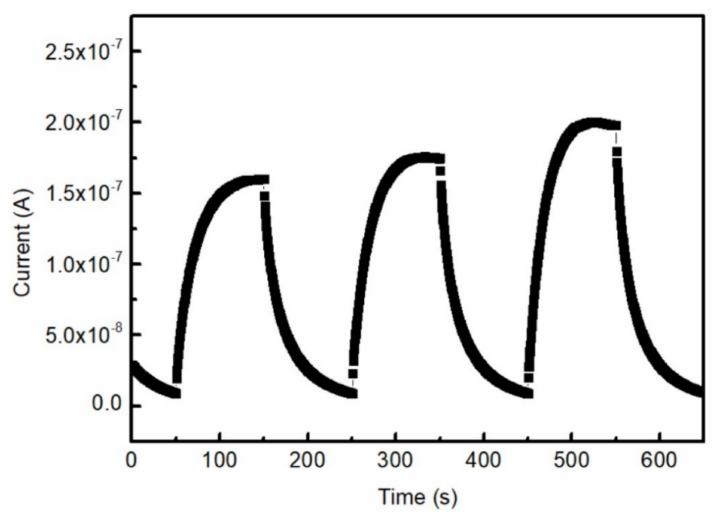
Figure 7. I–T characteristics of AGZO PTFT (AGO:ZnO = 60:60) in the dark and under illumination of 280 nm with V G = − 3 V and V D = 2